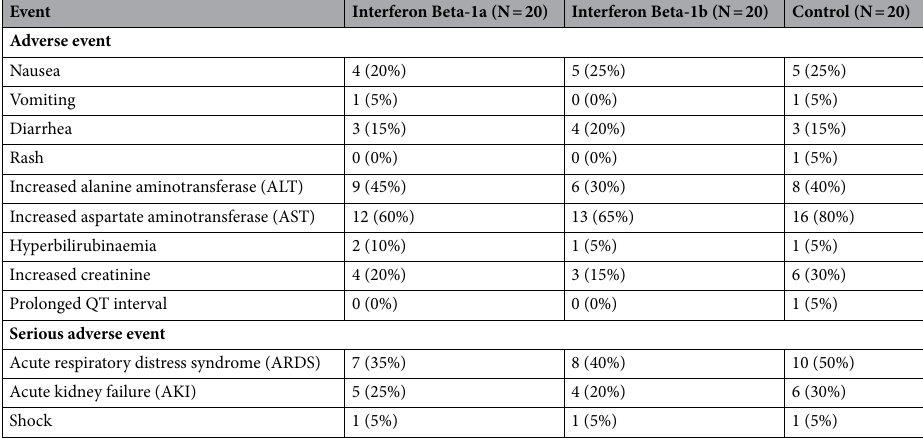
Table 3. Adverse events in the safety population. Adverse events that occurred in more than one patient after randomization through day 21 are shown. Some patients had more than one adverse event. All deaths were due to respiratory failure. No statistically significant differences were observed between the three